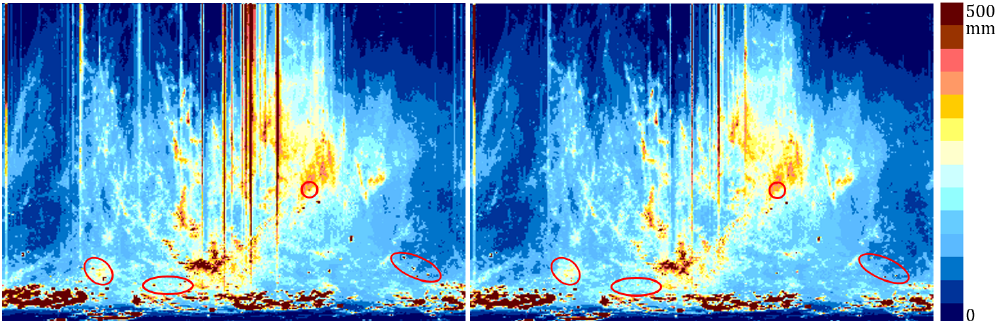
Figure 5. Example of the performance of the DP.TURBINE algorithm from the left: raw data and data after detection of non-meteorological echoes by means of DP.TURBINE and their interpolation with INTERP. Ram˙za radar, monthly accumulation of precipitation, the lowest elevation, September 2018. The red ellipses show examples of echoes from wind turbines.